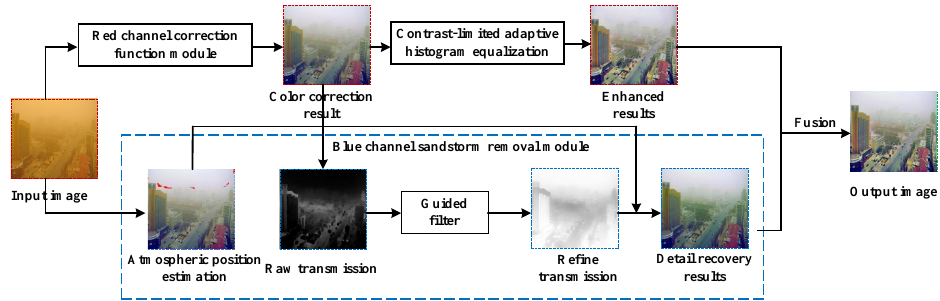
Figure 2. Flowchart of sand-dust image restoration method based on red and blue channel. First, the original sand dust image is corrected by the red channel correction function module to overcome the problem of yellow or red color deviation in sand dust